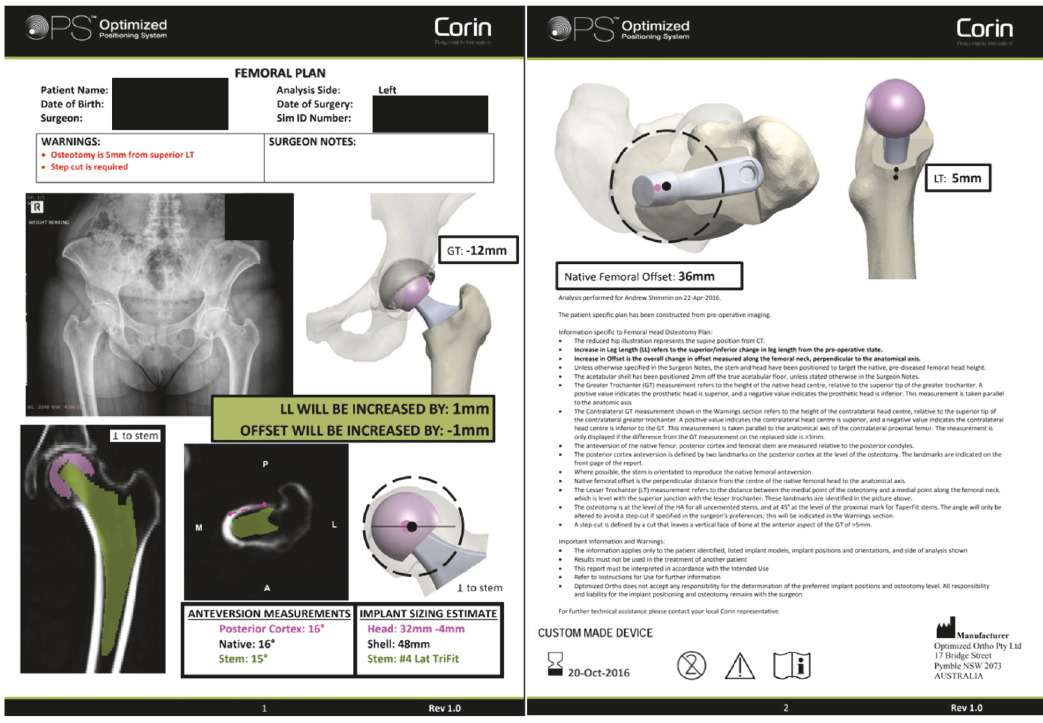
Figure 1: Case example of a presurgical plan developed using the OPS (cid:2) system, analyzed to assess the presence and size of anterior femoral neck osteophytes.